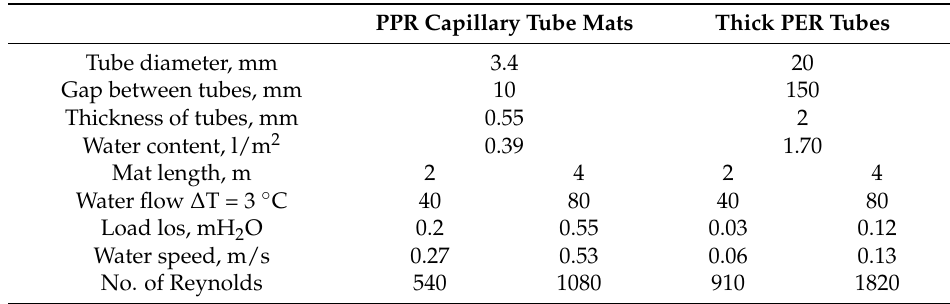
Table 1. The comparison between 20 mm diameter cross-linked polyethylene tubes and capillary tubes, for a cold emission of 70 W/m 2 with a 1 m wide and 2 m or 4 m long